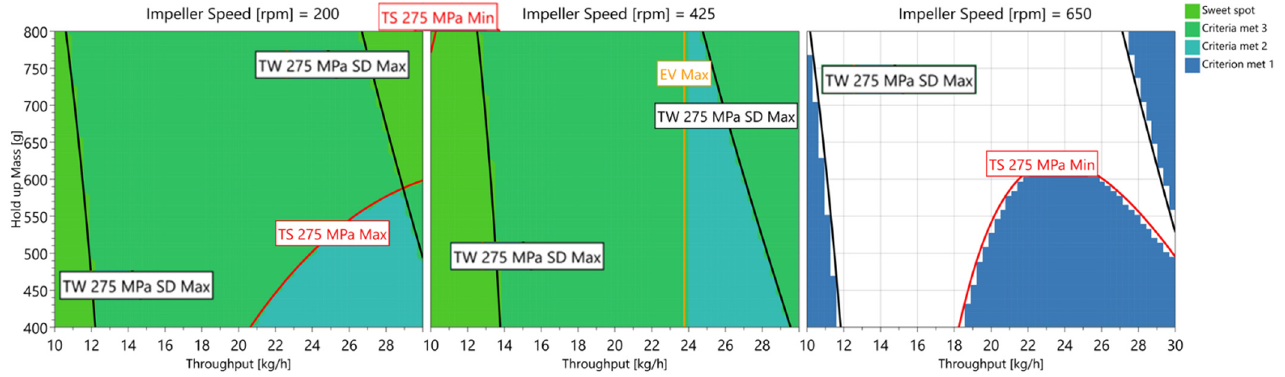
Figure 20. Sweet spot (light green) reveals the combination of the DoE input variables in which the criteria are met. The color of the borders indicate which criterion is not met anymore. Black borders = TW SD, red borders = TS and orange boarders = EV.